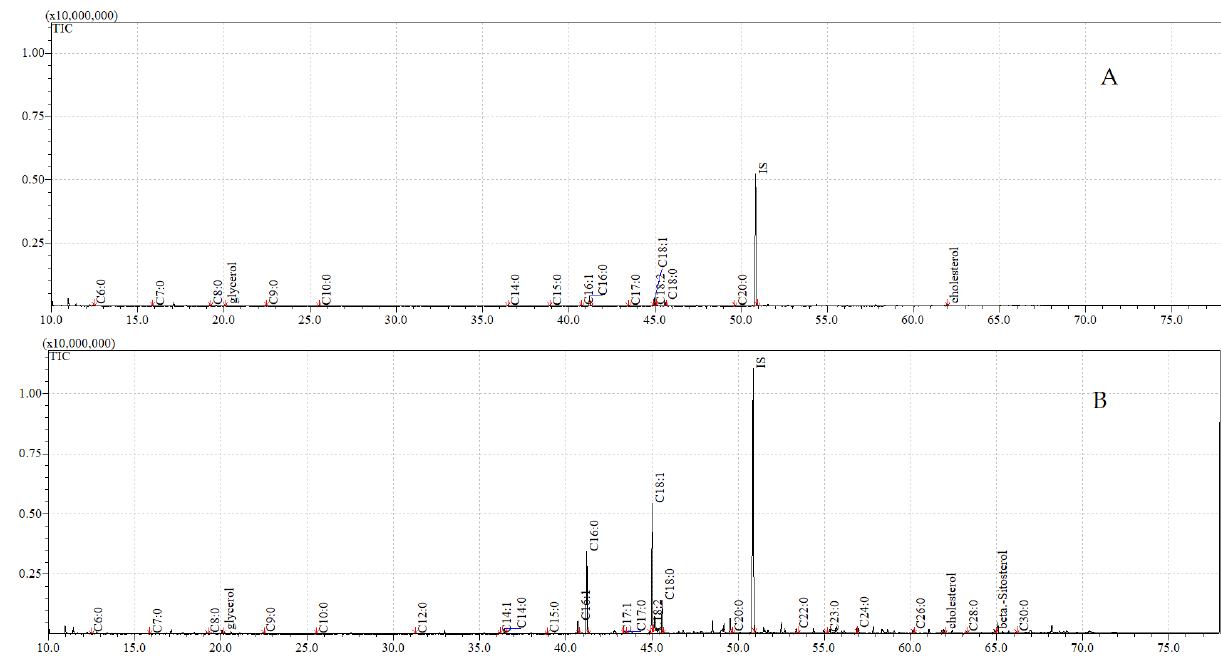
Figure 4. The total ion current (TIC) chromatogram of fatty acids (TMS esters) of the dichloromethane extract after sonification (extract III) from control (A) and after C. coronatus exposition (B) S. argyrostoma pupae . Internal standard (IS, 19-methylarachidic acid); the following fatty acids and molecular ions: hexanoic acid (C6:0, m / z = 188), heptanoic